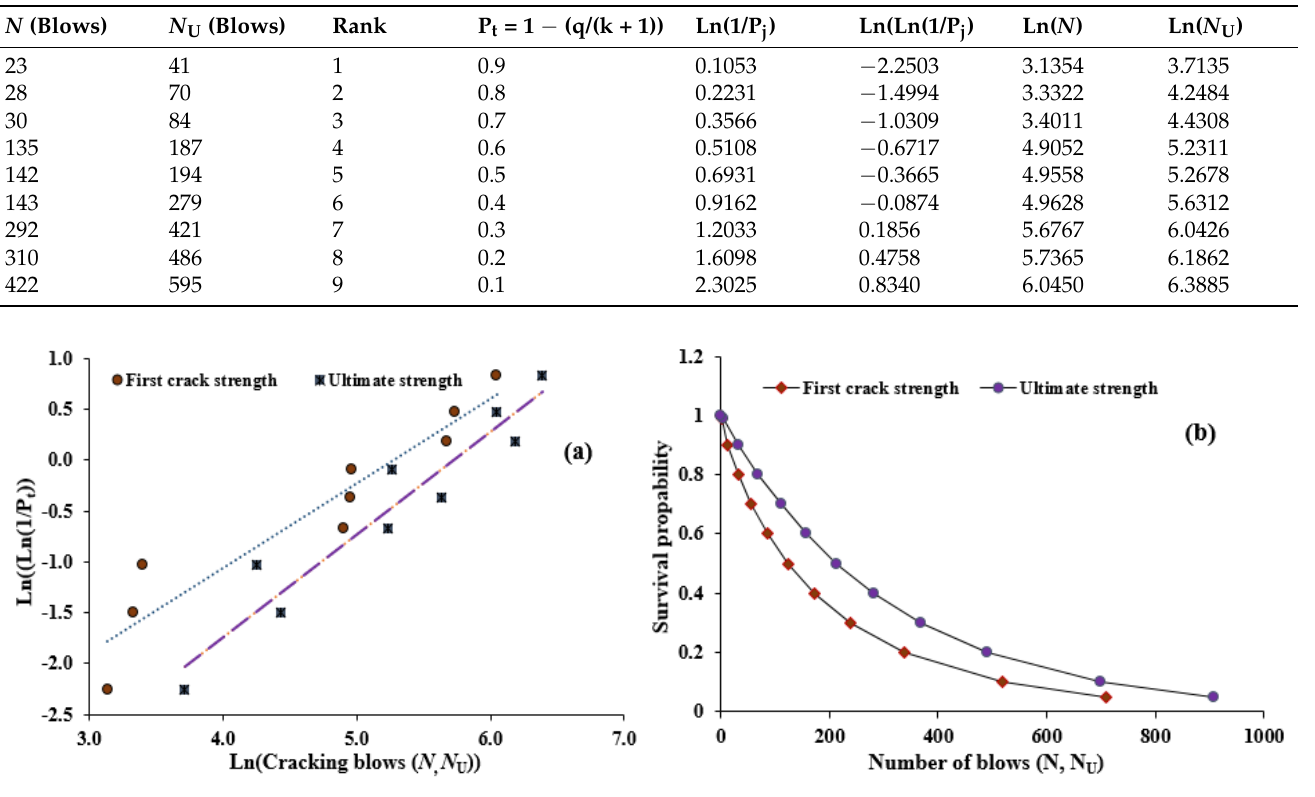
Figure 8. ( a ) Weibull distribution plots and ( b ) reliability probabilities for impact resistance.